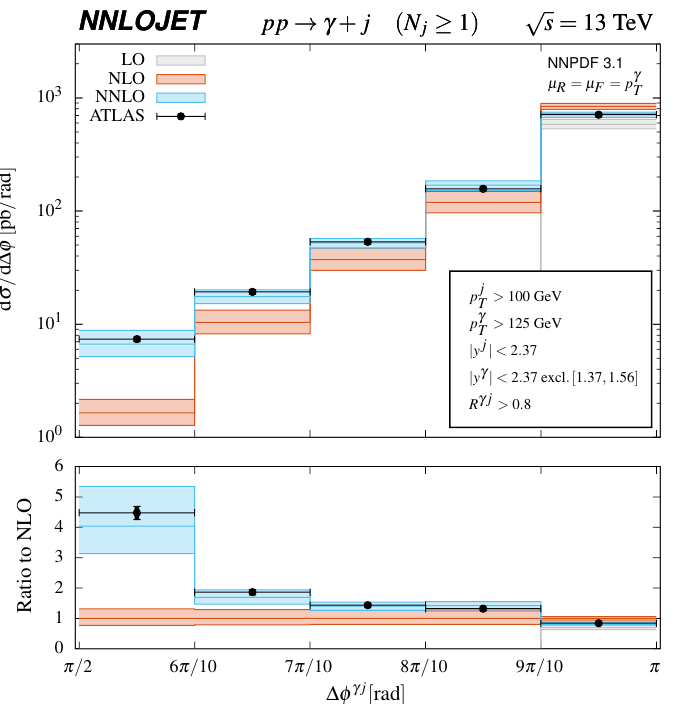
Figure 14 . Azimuthal separation of the photon and the leading jet, at LO, NLO and NNLO. The predictions are compared to ATLAS data